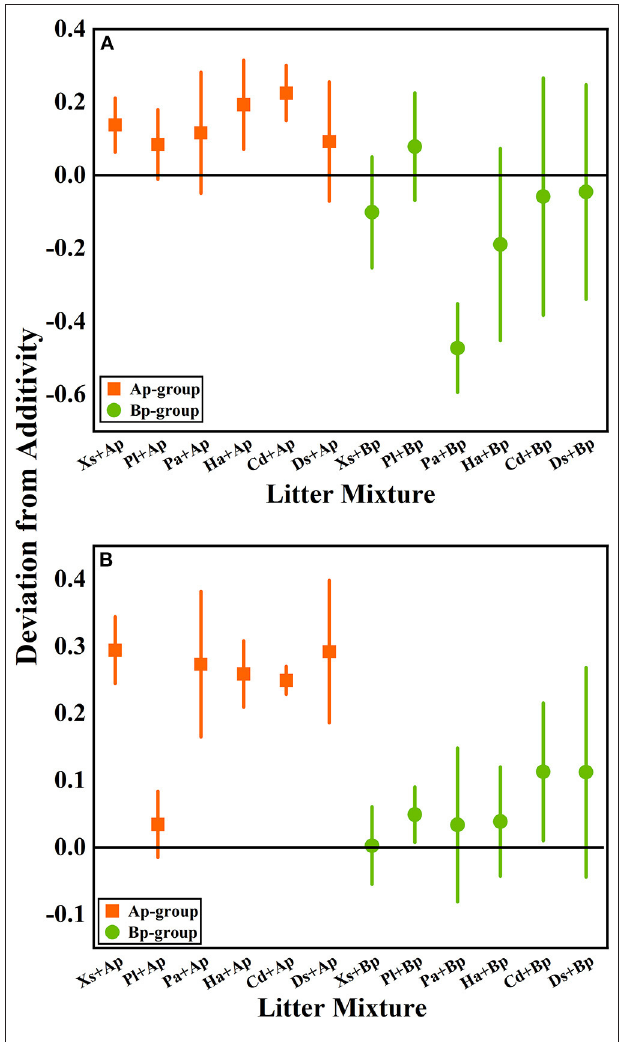
FIGURE 2 | The mean mixing effect intensity of litter mixture mass remaining in the hydro-fluctuation zone (A) and terrestrial zone (B) . The Ap-group indicates litter mixtures of A. philoxeroides and native species, and the Bp-group represents litter mixtures of B. pilosa and native species. All data are presented as mean ± standard deviation. In the mean mixing effect intensity values, values above 0 indicate synergistic effects, and values below 0 indicate inhibitory effects. Xs, X. sibiricum ; Pl, P. lapathifolium ; Pa, P. alkekengi ; Ha, H. altissima ; Cd, C. dactylon ; Ds, D. sanguinalis ; Ap, A. philoxeroides ; Bp, B. pilosa .